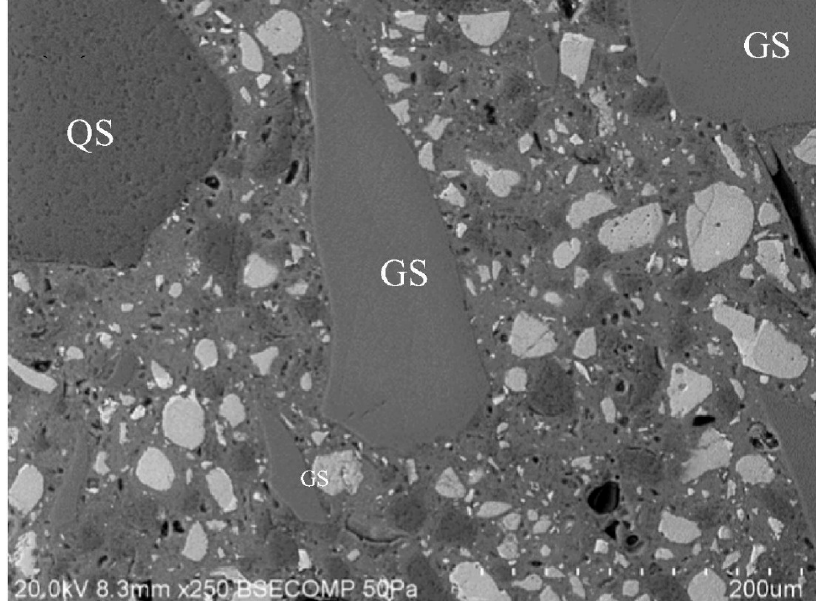
Figure 17. Microstructure of composite containing quartz and glass sand (glass mean particle size = 275 µm) [106].